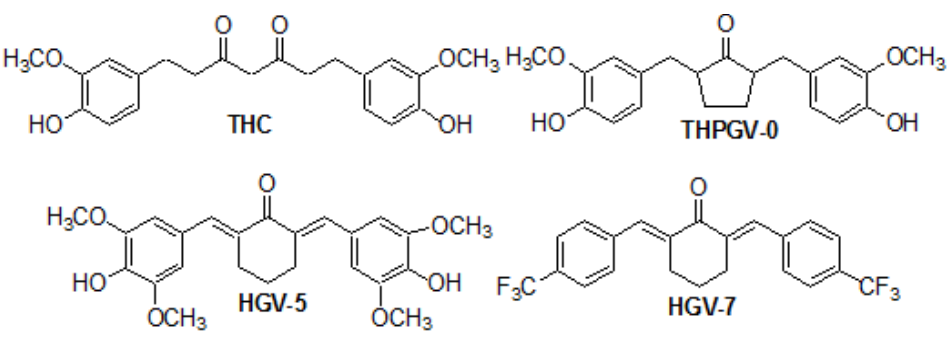
Figure 1. Chemical Structure of THC, THPGV-0, HGV-5 and HGV-7